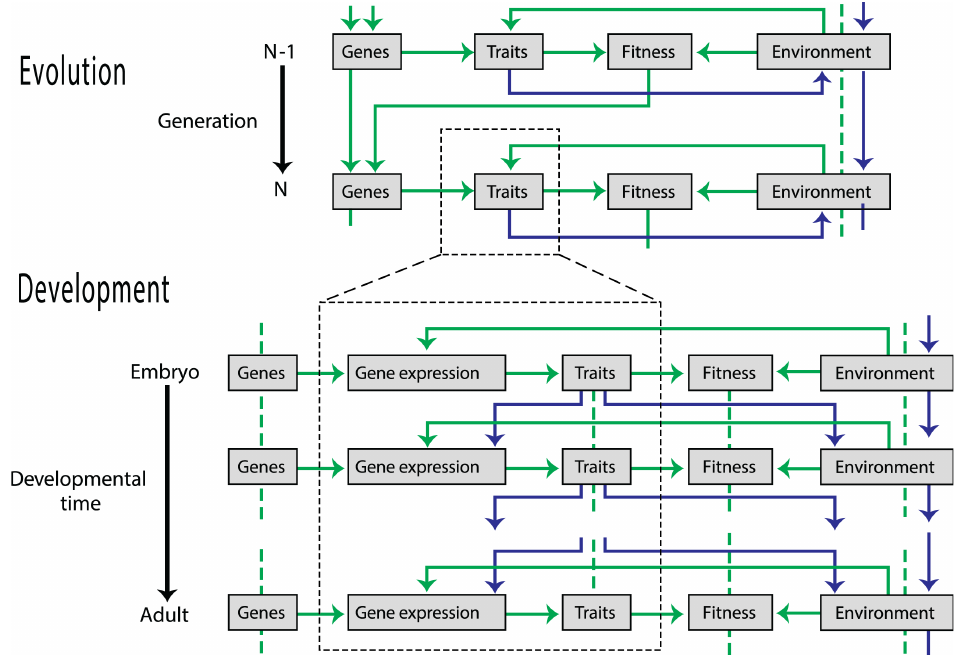
Matthew Allen, Graphs Depicting the Causal Pathways involved in the Evolution and Development of Traits: A Modern Developmental Perspective , after the diagram published in Kevin N. Laland et al., "Cause and Effect in Biology Revisited: Is Mayr’s Proximate-Ultimate Dichotomy Still Useful?," Science 224 (2011), 1513 (photo: